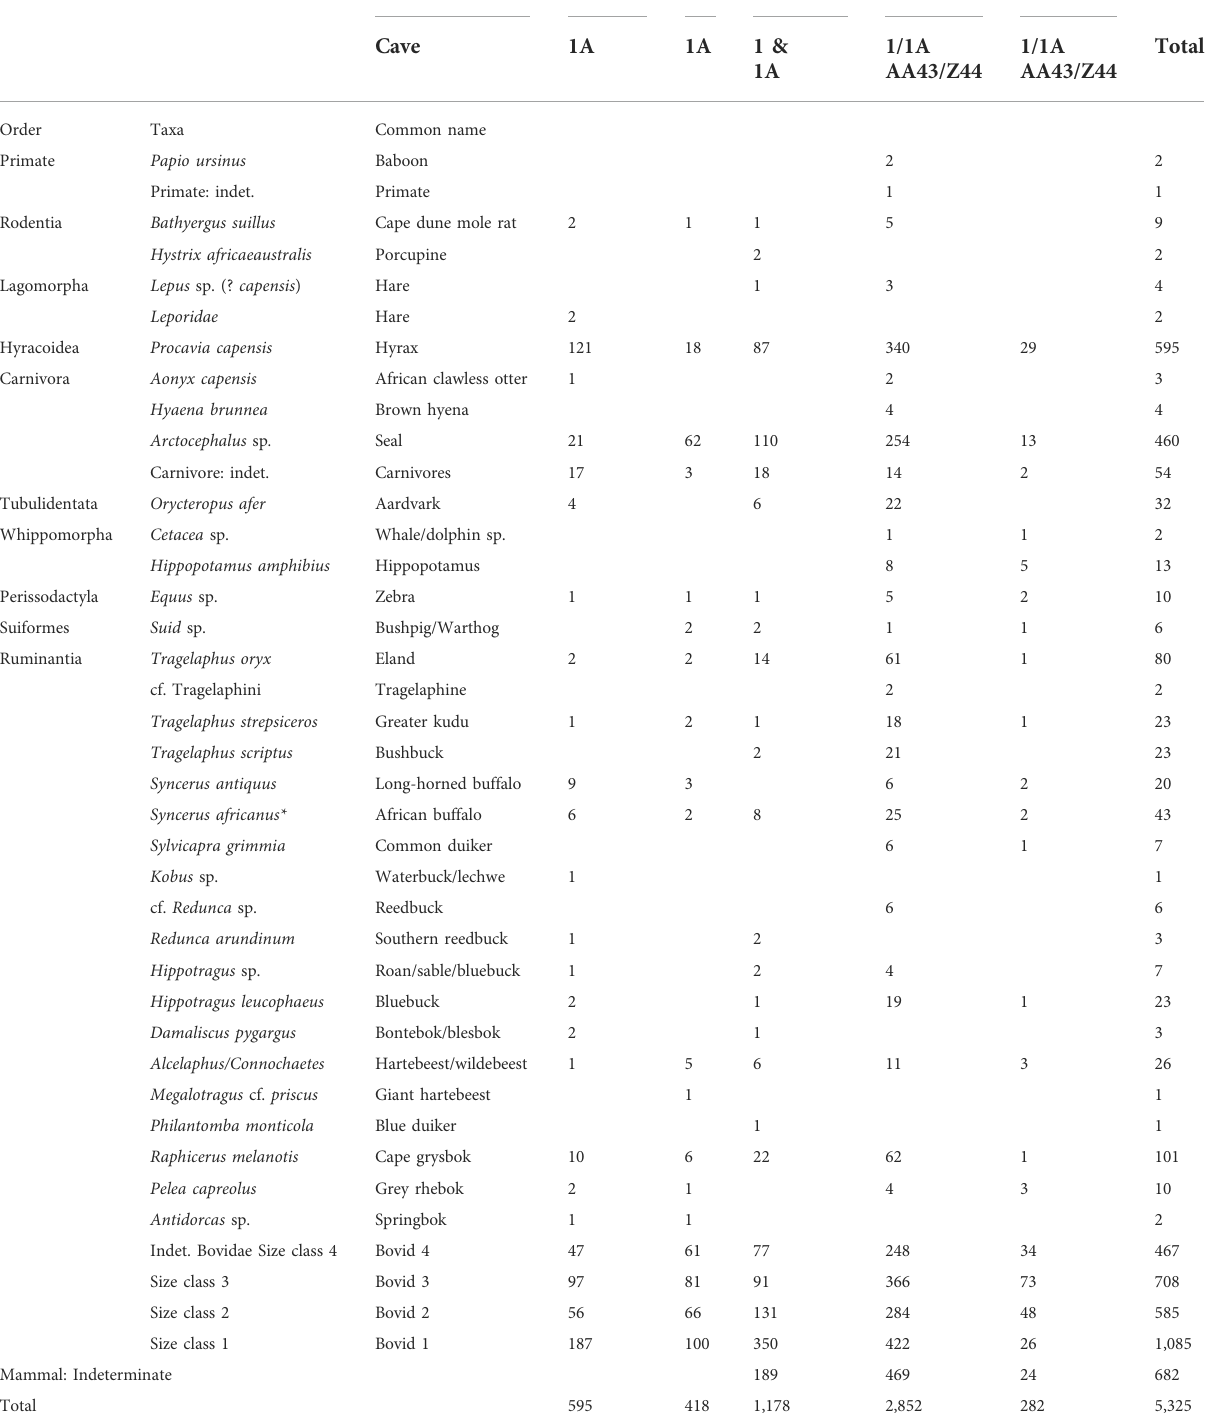
TABLE 3 Number of identi fi ed specimens (NISP) in cave 1 and 1A at Klasies River. Data from Reynard and Wurz (2020). Taxonomic names based on Skinner and Chimimba